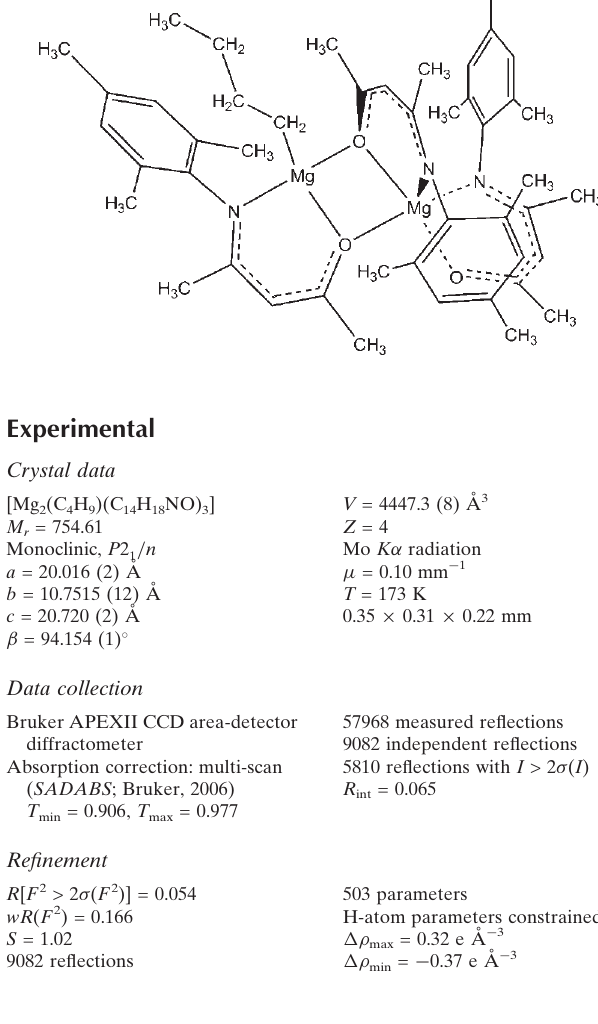
Comparative mean bond distances (A˚ ) to Mg in 4, 5 and 6-coordinate ketiminate complexes.